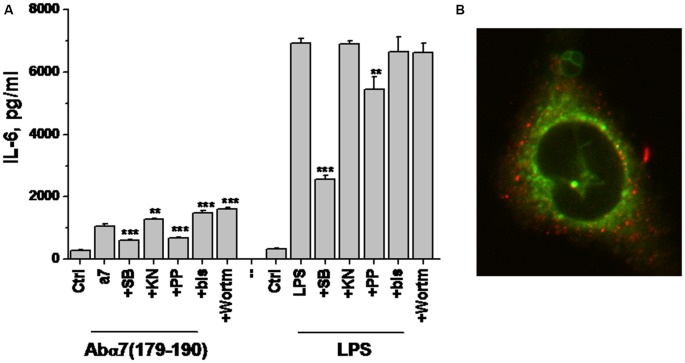
IL-6 production by U373 cells stimulated with either α7(179–190)-specific antibody or LPS in the presence or absence of various kinase inhibitors (A) and confocal image of U373 cell with internalized α7-specific antibody (red) additionally stained with MitoTracker (green; B). SB—SB202190 (p38 inhibitor), KN—KN62 (CaKMII inhibitor), PP—PP1 (Src kinase inhibitor), bis—bisindolylmaleimide (protein kinase C inhibitor), Wortm—Wortmaninn (phosphatidylinositol-3-kinase inhibitor). **p < 0.005; ***p < 0.0005 compared to the effect of LPS or α7-specific antibody alone.